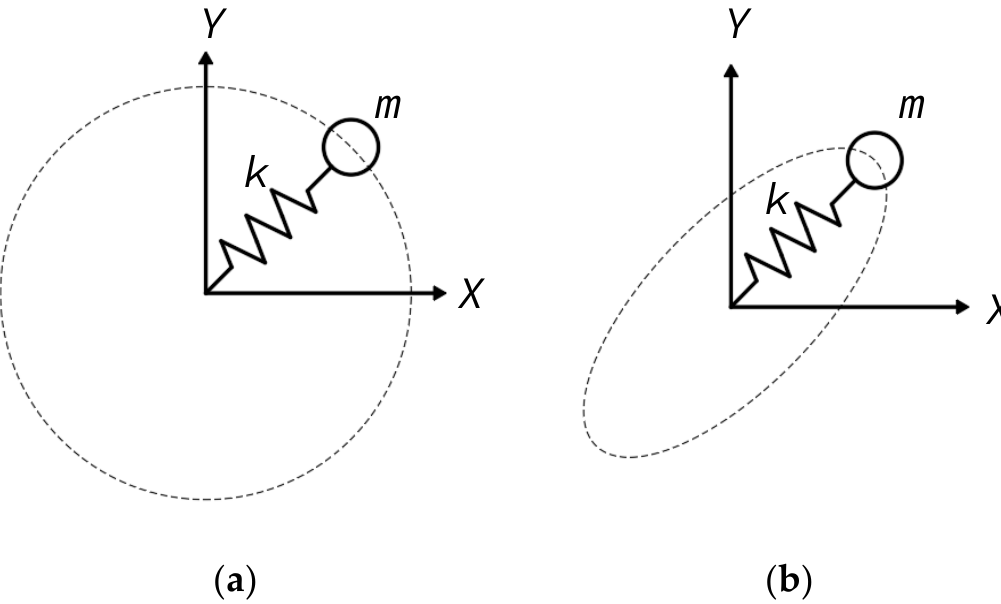
Figure 8. Shaft orbit: ( a ) circular motion; ( b ) elliptical motion.